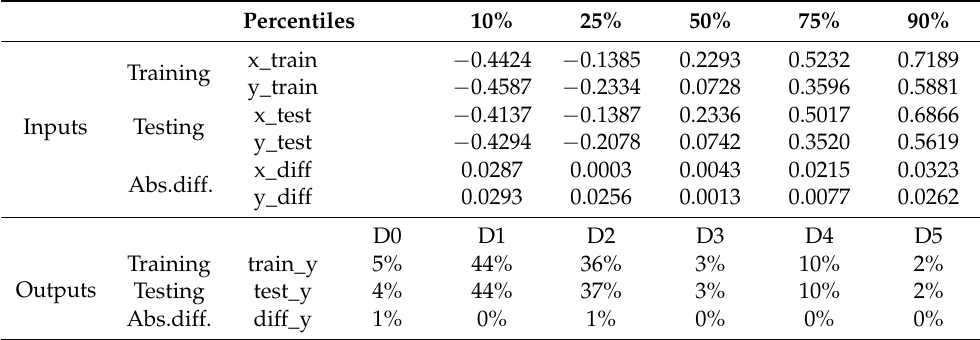
Table 4. Training and Testing dataset similarity for NW